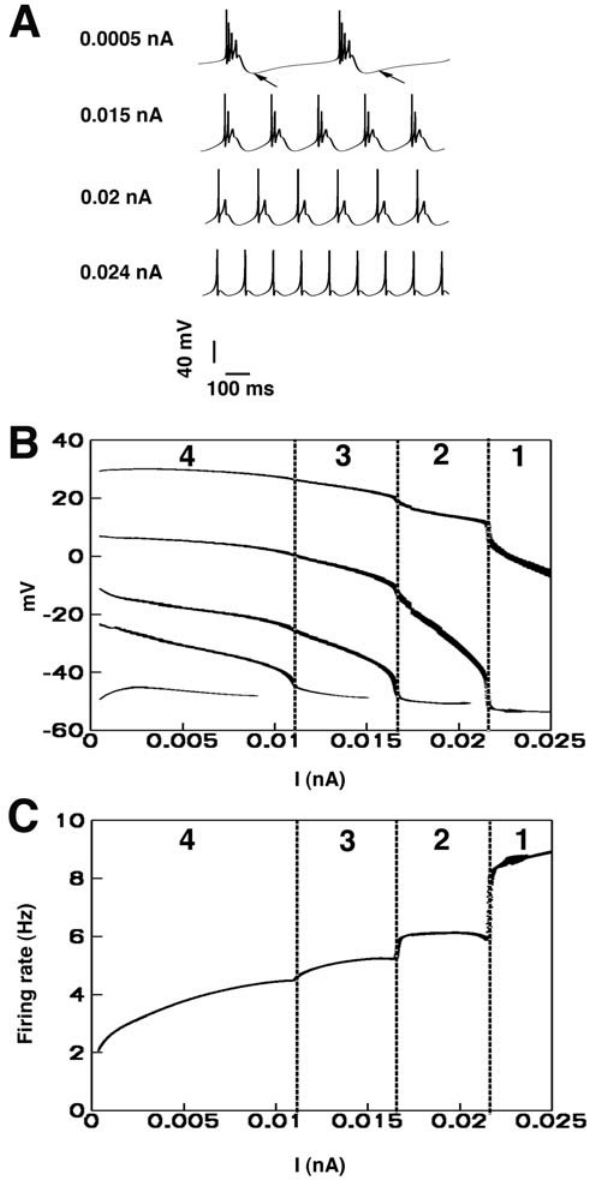
Figure 2. The CA3 neuron exhibits distinct firing modes in response to continuous current injection. (A) Simulated neuronal firing in the CA3 neuron. For smaller amplitude stimulus current, the neuron fires bursts at low frequency (0.0005 nA, 0.015 nA, and 0.02 nA). The burst morphology consistently occurs as a burst of two or more action potentials. With increasing levels of injected stimulus current, the firing becomes regular spiking (0.024 nA). Note that the prominent afterhyperpolarizations observed in experimental recordings are reproduced in the model (Arrows in A). (B) The maximum values of V m for each spike within a burst (recorded at psuedo-steady-state between 9000 ms and 10000 ms) are shown at each value of injection current I (nA). Vertical dashed lines divide the graph into the four zones. The number in each zone indicates the number of spikes in each burst. (C) The intra-burst frequencies are shown at each value of injection current I (nA). Vertical dashed lines divide the graph into the four zones corresponding to those in B. The number in each zone indicates the number of spikes in each